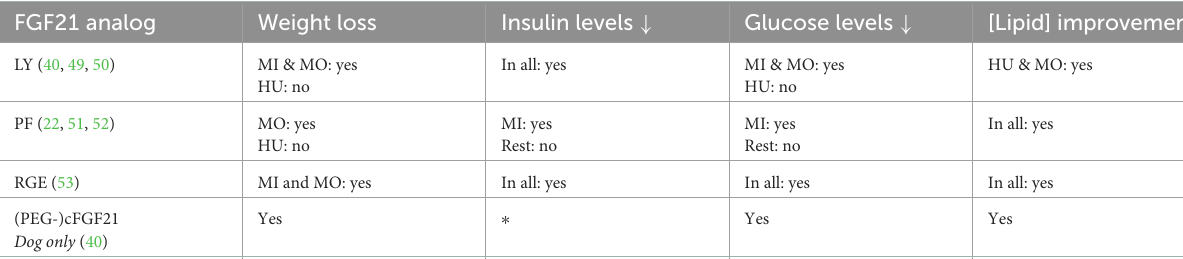
TABLE 2 Summary of species-specific findings of FGF21 analogs. FGF21